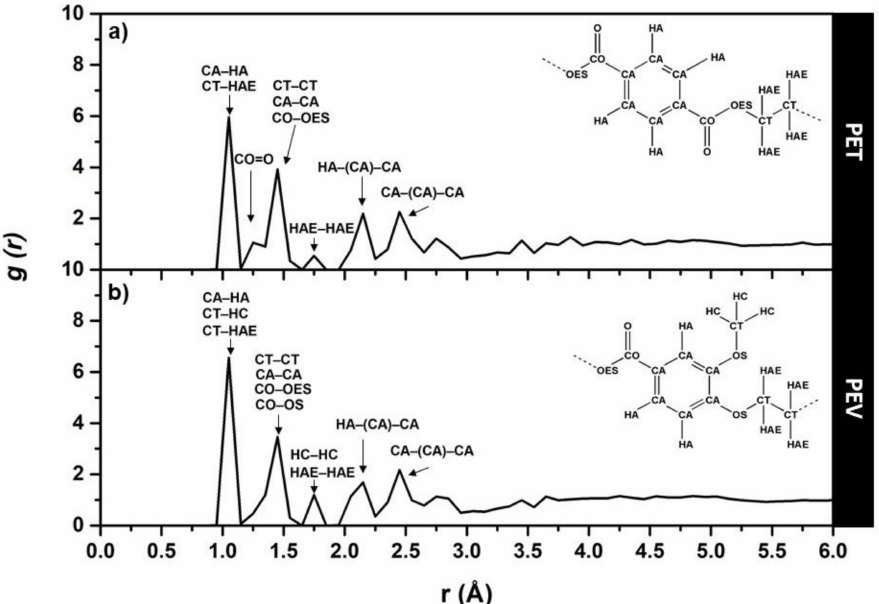
Figure 5. Total RDFs, g(r), for simulations at 300 K and 1 atm of ( a ) PET and ( b ) PEV polymers. Gener- ally, the intramolecular peaks of the monomer unit are located within 4.50 Å. The atoms CA, CO, CT, O, OES, OS, HA, and HAE represent the aromatic carbon, carbonyl carbon, ethylene carbon, carbonyl oxygen, ester oxygen, ether oxygen, aromatic hydrogen, and ethylene hydrogen, respectively.